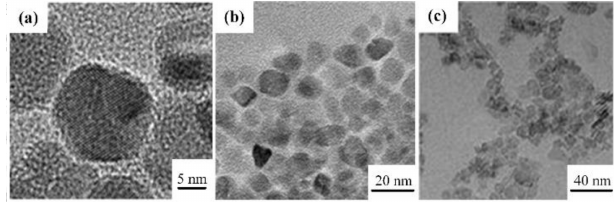
Figure 1. HRTEM (High Resolution Transmission Electron Microscopy) images for three types of nanoparticles: ( a ) Fe 3 O 4 ; ( b ) TiO 2 ; ( c ) Al 2 O 3